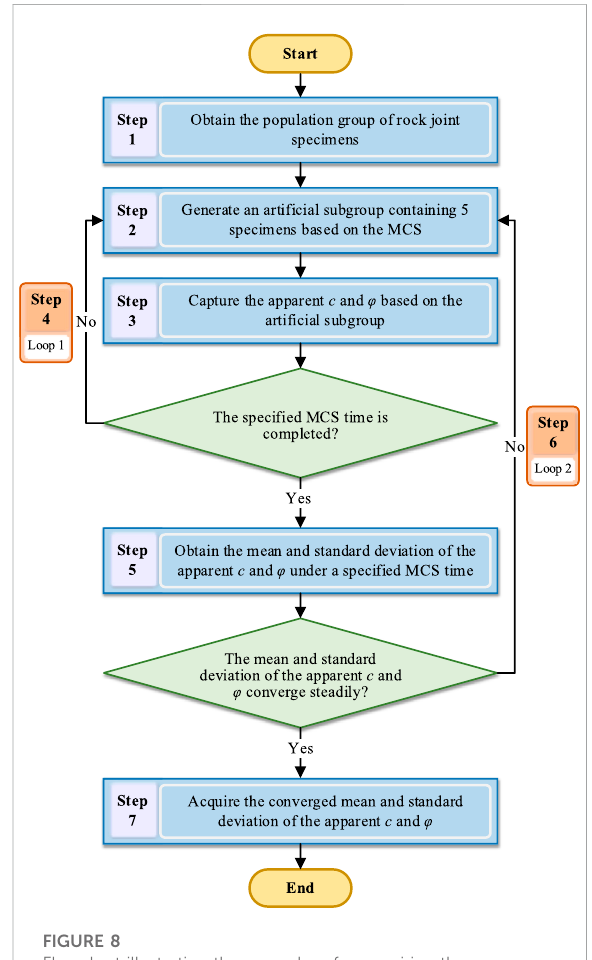
FIGURE 8 Flowchart illustrating the procedure for acquiring the converged mean and standard deviation of the apparent c and φ